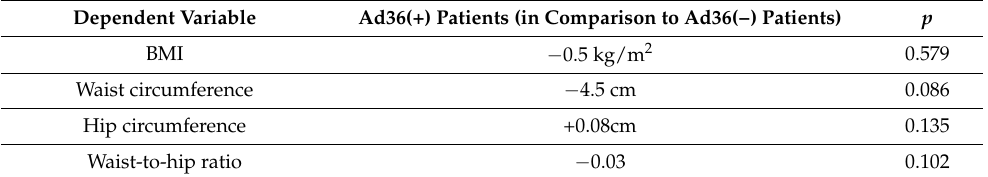
Table 2. Adv36-serostatus and anthropometric measurements adjusted through multiple regression analysis by: age, gender, sexuality (MSM vs. other), ARV therapy (receiving TAF vs. not receiving TAF; receiving an INSTI vs. not receiving an INSTI), and CD4 +